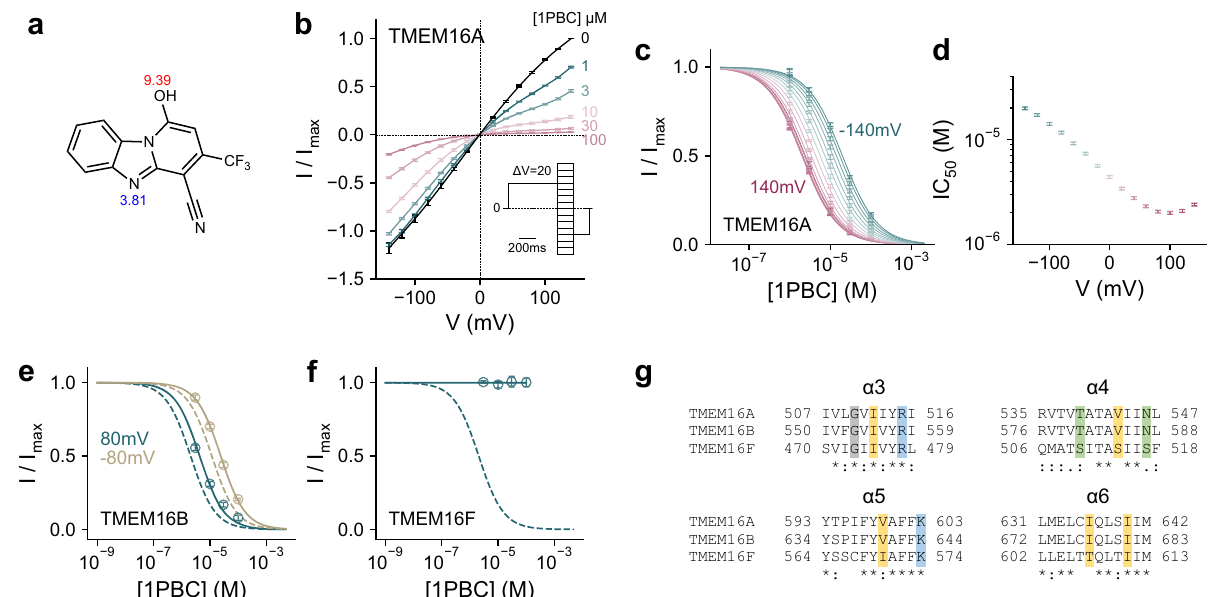
Fig. 1 Functional characterization of the TMEM16A blocker 1PBC. a Chemical structure of 1PBC. The pKa values of ionizable groups were calculated with the chemistry package Chemicalize (ChemAxon, https://chemicalize.com/). b Steady-state current-voltage relationship of wild-type mouse TMEM16A at the indicated concentrations of 1PBC applied to the intracellular side of the membrane at 2 µ M intracellular Ca 2 + . Data are averages of 6 biological replicates, errors are SEM. c Concentration-response relations of 1PBC at voltages from − 140 to 140 mV, Δ V = 20 mV. Data are calculated from b , errors are SEM. Solid lines are fi ts to the Hill equation. d IC 50 values obtained from ( c ) at the indicated voltages. Data are best- fi t values, errors are 95% CI. Concentration-response relations of 1PBC of mouse TMEM16B ( e ) and TMEM16F ( f ) at 15 and 300 µ M intracellular Ca 2 + respectively at − 80 and 80 mV. Data are averages of 5 and 6 biological replicates respectively, errors are SEM. Solid lines are fi ts to the Hill equation. Dashed lines are the relations of TMEM16A. g Sequence alignment of the outer pore region of mouse TMEM16A (UniProt ID: Q8BHY3), mouse TMEM16B (UniProt ID: Q8CFW1), and mouse TMEM16F (UniProt ID: Q6P9J9). Sequence identity between TMEM16A and B, 60.5%; between TMEM16A and F, 39.5%. A conserved glycine in α 3 is highlighted in gray and other colors indicate the type of the residues interacting with the blocker (yellow, hydrophobic; green, polar; blue, basic) in TMEM16A.